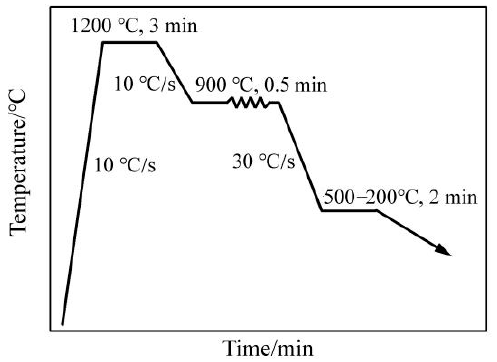
Figure 1. Schematic diagram of thermal simulation process.